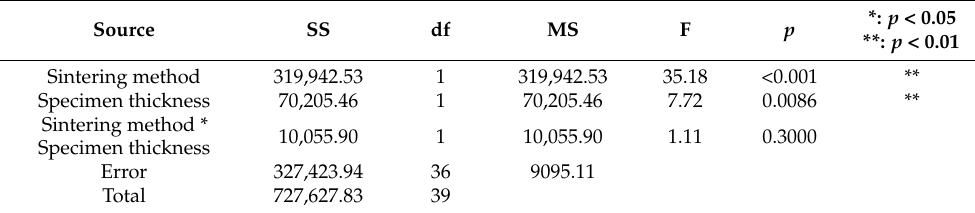
Figure 13. Fracture toughness of 5Y-SS and 5Y CS. Table 5. Results of two-way ANOVA statistical analysis for three-point flexural test.